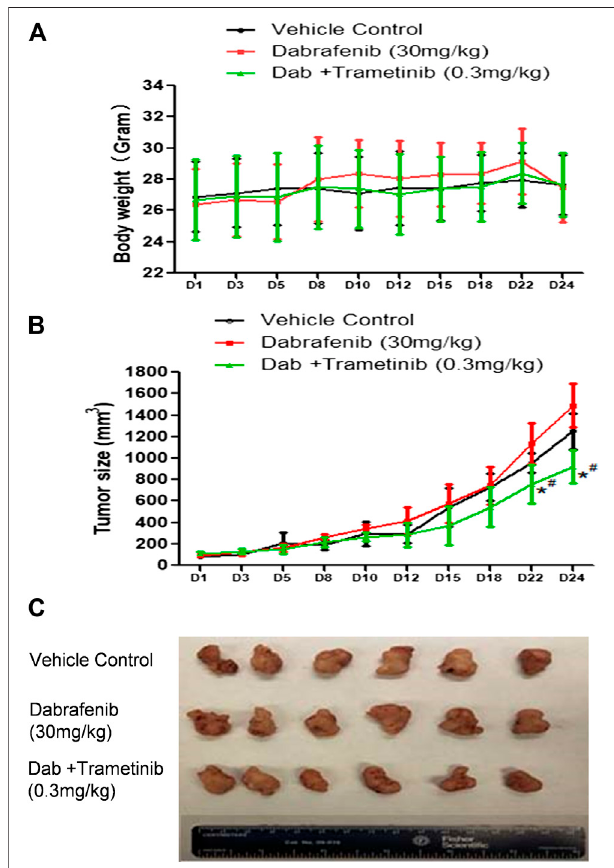
FIGURE 4 | Synergistic effect of BRAF inhibitor dabrafenib and MEK inhibitortrametinib (A) Micebodyweightcurvesduringtheadministrationtime period (B) Tumor growth curve. *, p < 0.05, compared with Vehicle treatment groups.#, p < 0.05,comparedwithDabtreatmentgroup. (C) Picturesof isolated tumor tissue.